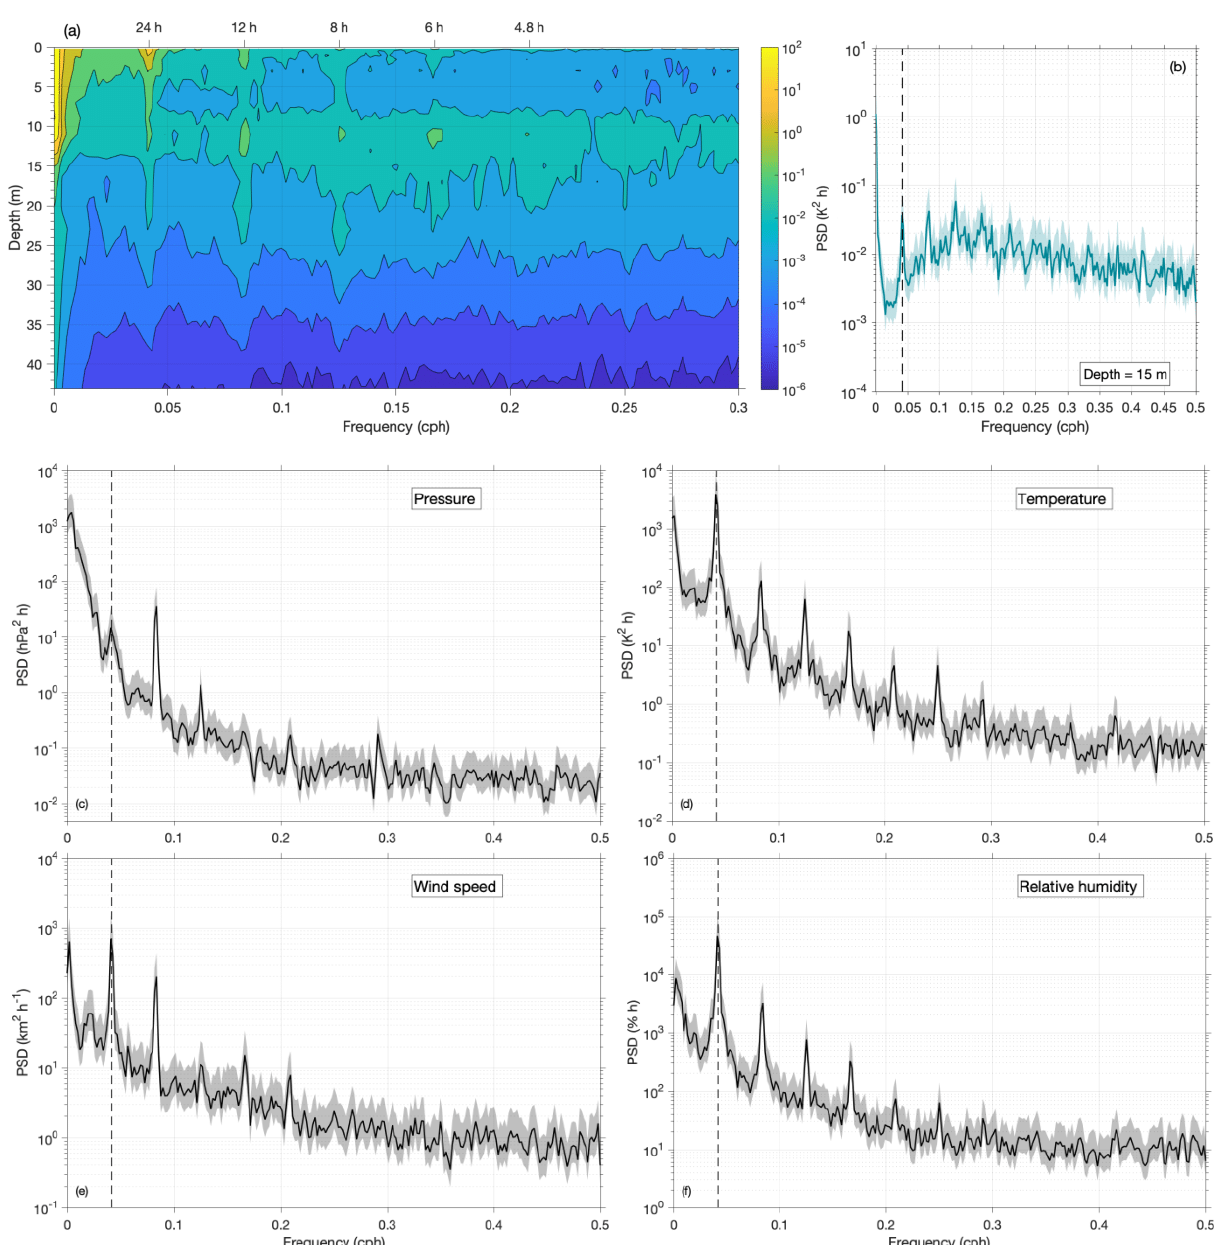
Figure 5. Power spectral densities (PSDs) for lake temperatures at various depths (a) , at a depth of 15m (b) , and for the air pressure (c) , air temperature (d) , wind speed (e) , and relative humidity (f) for the entire observation period. All PSDs were computed from the hourly mean values as described in Sect. 3.2. Full lines and shaded areas in panels (b–f) depict PSDs and 95% confidence intervals, respectively, whereas vertical dashed lines indicate the 24h period. Frequencies are given in cycles per hour